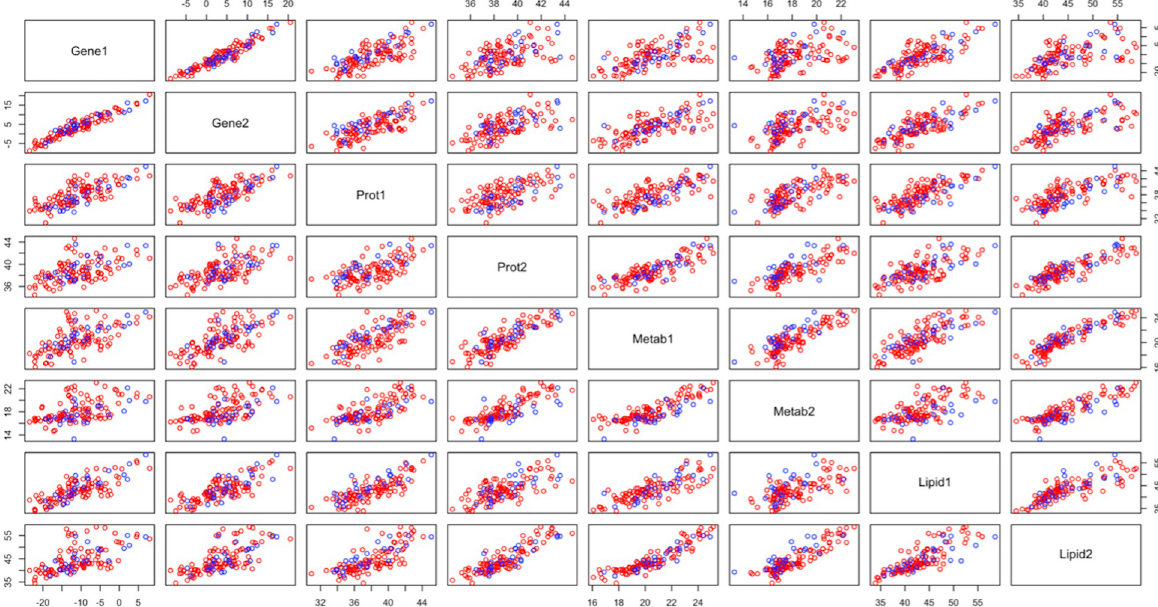
Fig 14. smCCA scores. Plot of the pairwise scores from smCCA. Note the red points are patients with COVID-19 and the blue are patients without.